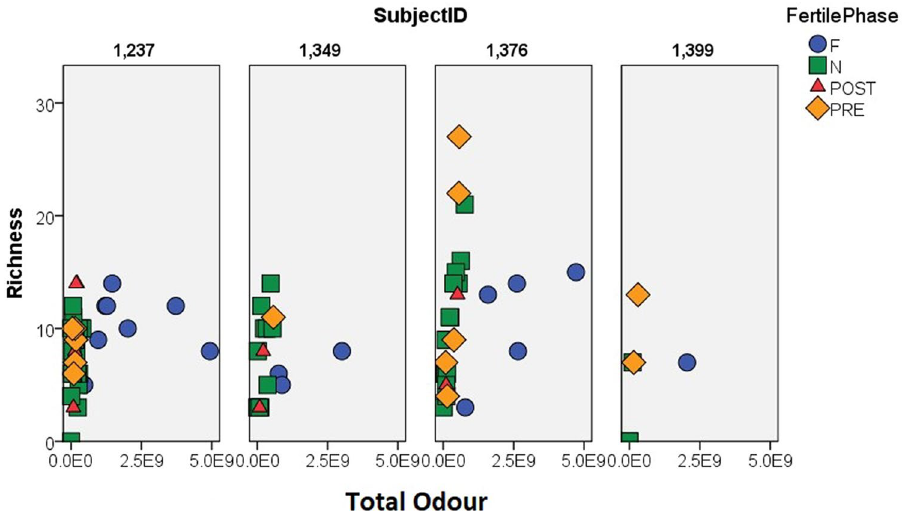
Figure 4. Scatterplots of Total Odour (x-axis) and Richness (y-axis) for each female, showing how the samples differ by fertility phase. The top row shows the FF females. The bottom row shows the MF females. Note that the Richness scale is smaller for the FF females. For both groups, Total Odour separates the fertile phase samples from the rest. F, N, Post, and Pre are fertile, non-fertile, post-fertile, and pre-fertile, respectively. FF indicates that the females are from an all-female group. MF indicates that the females are from a group with both